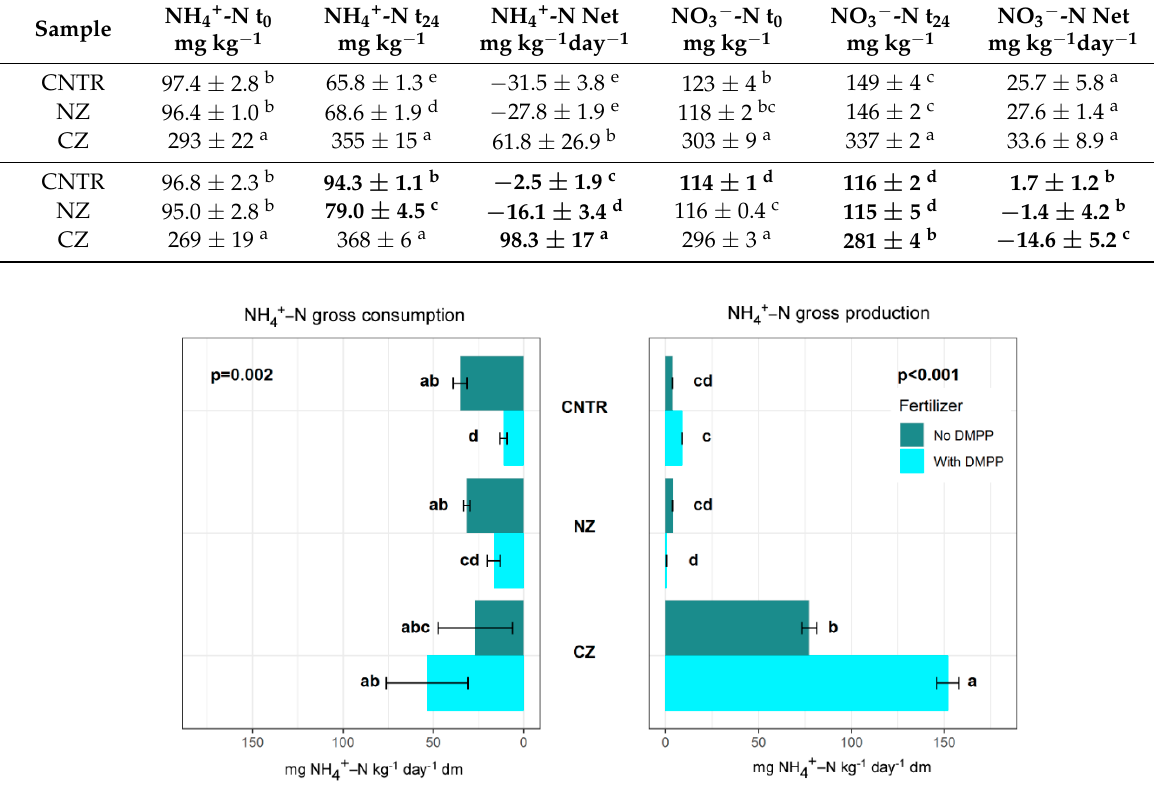
Figure 2. Gross NH 4+ -N consumption (on the left ) and gross NH 4+ -N production (on the right ) rates in treatments with and without DMPP addition. CNTR is the soil without any zeolite addition, NZ is the soil + 10 wt% of CHA zeolite in natural state while CZ is the soil + 10 wt% of NH 4+ - charged CHA zeolite. Error bars represent standard deviations (4 replicates) while different letters indicate significant differences between treatments as a result of ANOVA (for gross production), Kruskal-Wallis (for gross consumption) and Tukey (HSD) statistical tests ( p < 0.05).